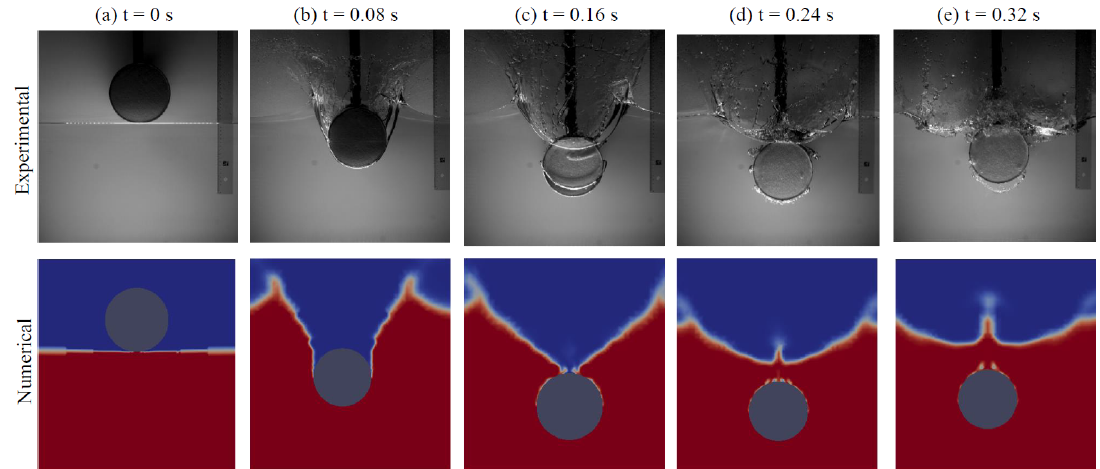
Figure 9. Evolution of the free surface for m = m 0 and h = 0.5 m. Comparison between CFD and experiments for different times after water impact: ( a ) t = 0 S; ( b ) t = 0.08 s; ( c ) t = 0.16 s; ( d ) t = 0.24 s; ( e ) t = 0.32 (s).